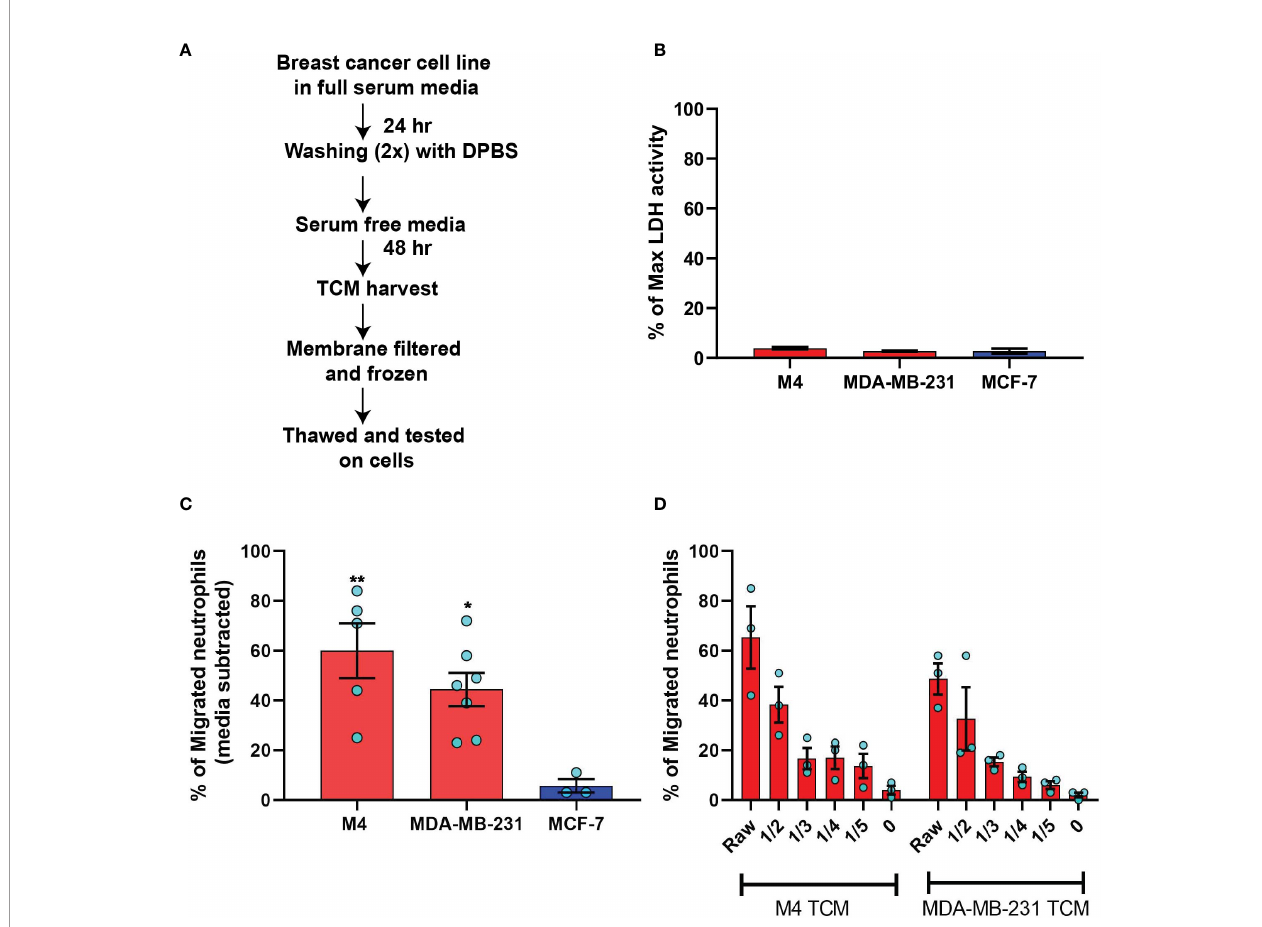
FIGURE 2 | TCM derived from serum deprived TNBC cell lines retain neutrophil recruiting ability. (A) Flowchart describing how TCM was generated and harvested from cell lines grown under serum free conditions. (B) Graph depicting spontaneous LDH activity in the supernatant of cancer cell lines grown under serum free conditions measured and normalized with respect to maximum LDH activity. Bars represent mean percentage of max LDH activity ± SEM from 3 independent experiments. (C) Graph depicting the percentage of neutrophils that migrated into the bottom chamber of the transwells containing equal volume of TCM from different breast cancer cell lines cultured in serum free condition. Red and blue bars represent values of neutrophil migration obtained with TCM harvested from TNBC and ER+ cancer cell lines, respectively. (D) Graph depicting the percent of neutrophils migrating into the bottom chamber of the transwells containing serially diluted equal volume of TCM from two different TNBC cell lines. Results are presented as mean ± SEM from N=3-7 (C) or N=3 (D) independent donors represented by individual dots. Each donor (N) represents an independent experiment. **P ≤ 0.005, *P ≤ 0.05 when compared with MCF-7 (one-way ANOVA with Dunnett ’ s multiple comparisons